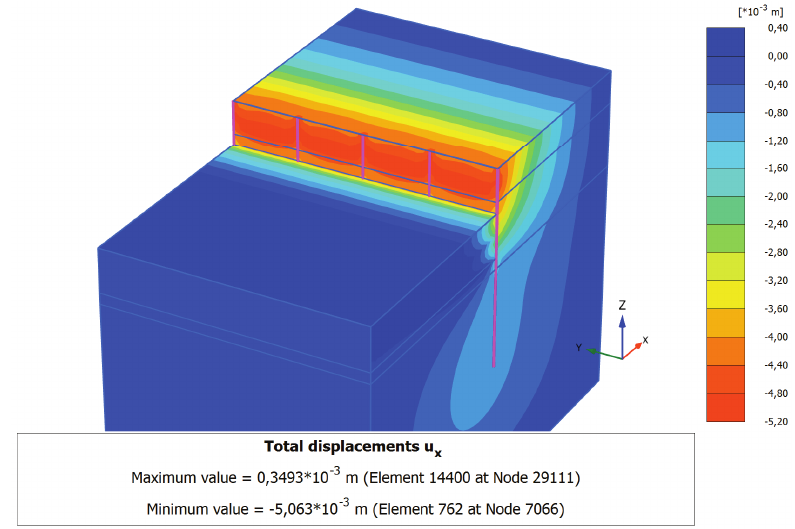
Fig. 10. Displacements of the computational model after the completion of the excavation